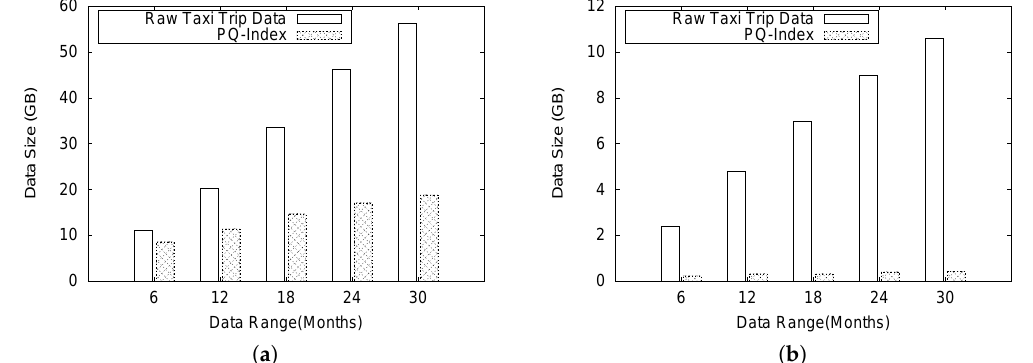
Figure 26. Data size comparison. ( a ) NewYork dataset; ( b ) Chicago